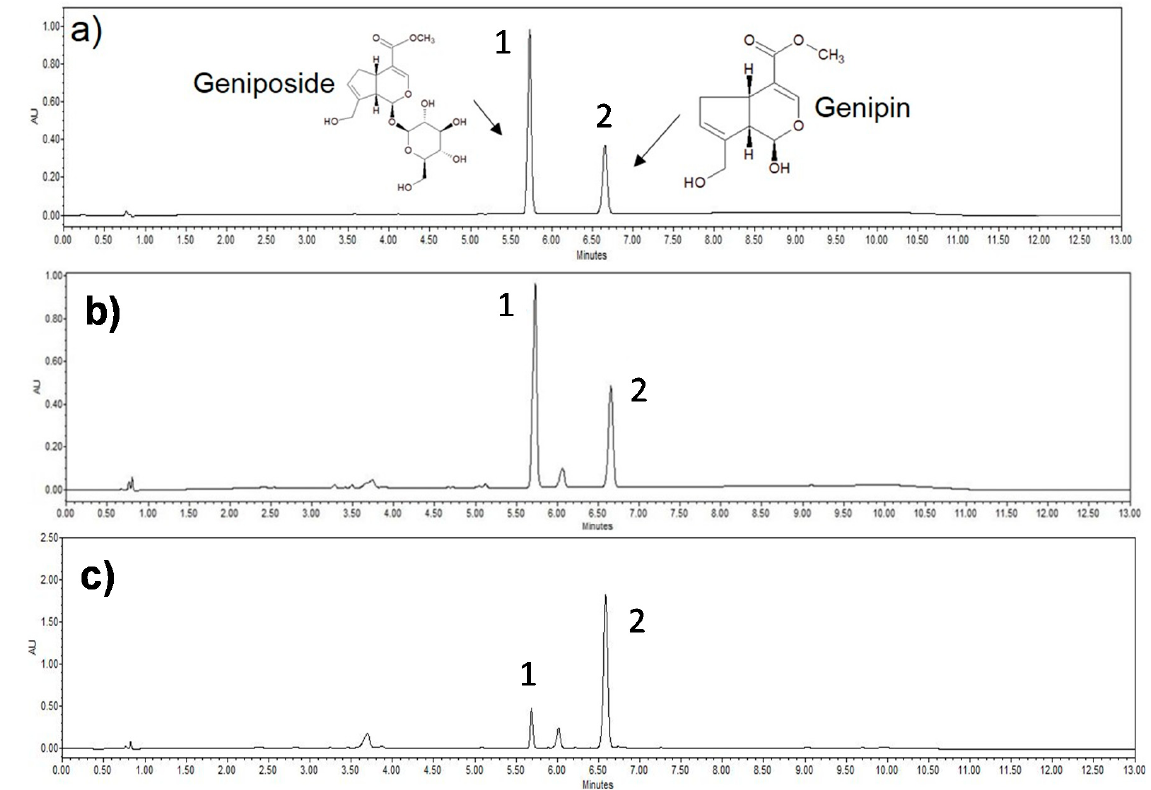
Figure 1. Representative HPLC/DAD chromatograms for genipin and geniposide recovered at 240 nm: ( a ) standard solution of genipin and geniposide, ( b ) ethanolic extract from SDG obtained at 150 W and 7 min, and ( c ) aqueous extract from SDG obtained at 150 W and 7 min. The retention times of geniposide and genipin were 5.73 and 6.65 min, respectively.